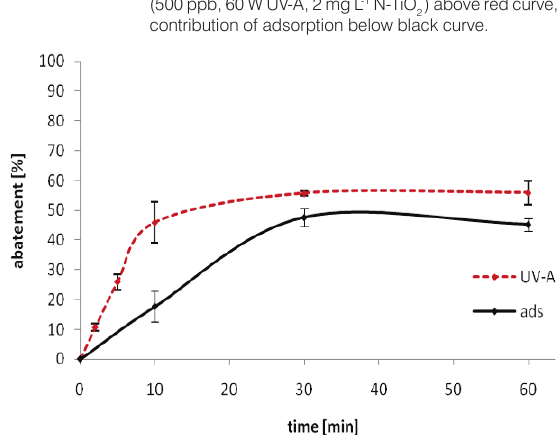
Figure 16. Photocatalytic assisted abatement of tetracycline under UV-A radiation by using iron modified TiO 2 photocatalysts Fe-TiO (above red curve), contribution 2 of adsorption to the abatement (below black curve).